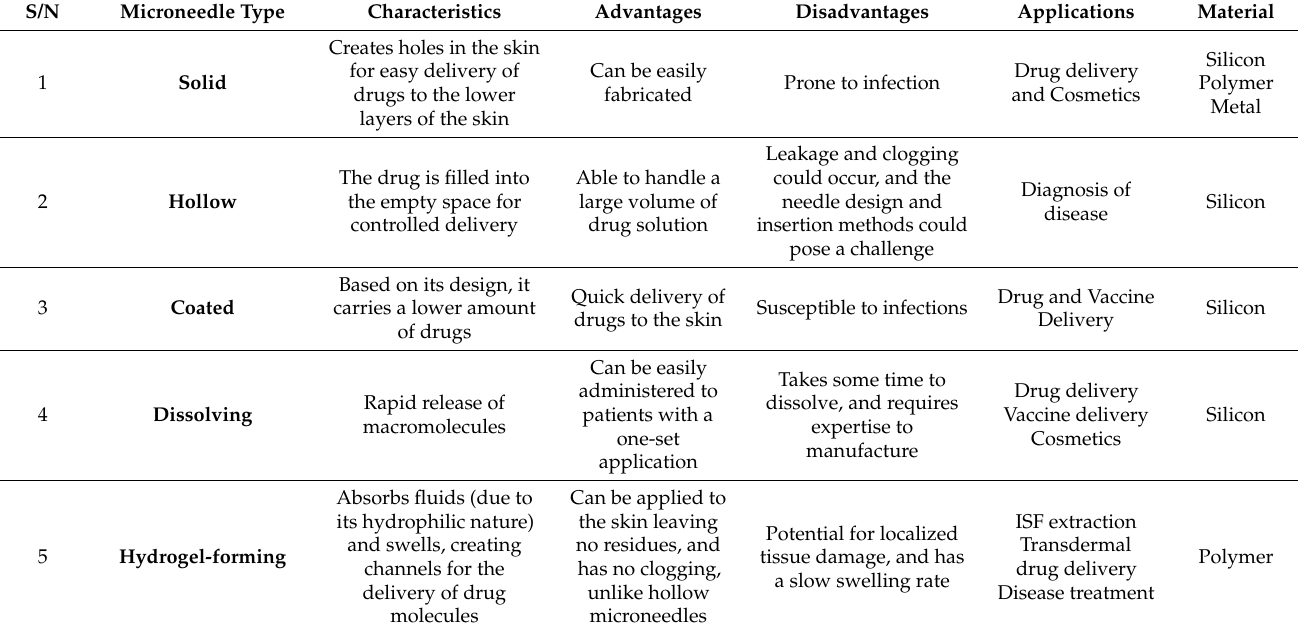
Table 3. An overview of the different types of microneedle material characteristics and benefits